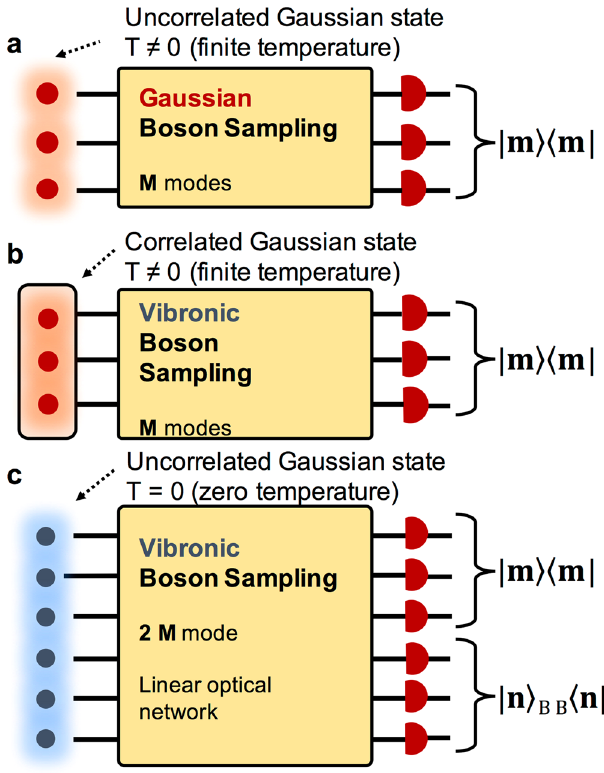
) enters into linear photon network. th